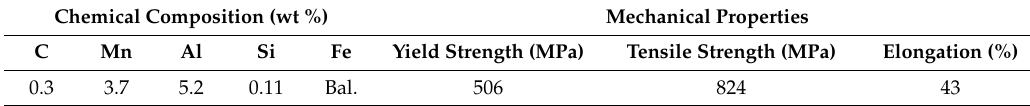
Table 1. Chemical composition and mechanical properties of base material.